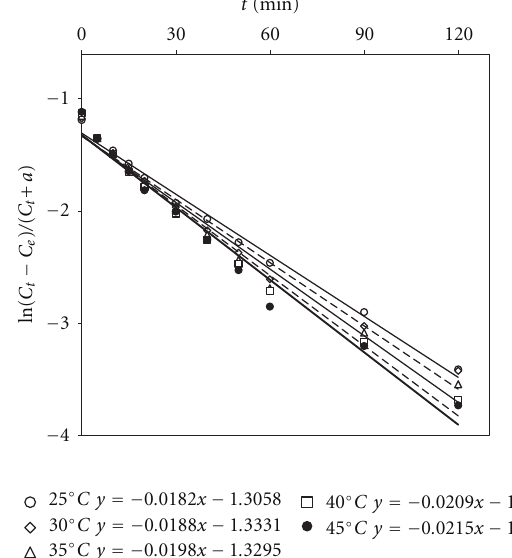
F3:Adsorbateremovalrateof2,4-Datdifferenttemperatures.